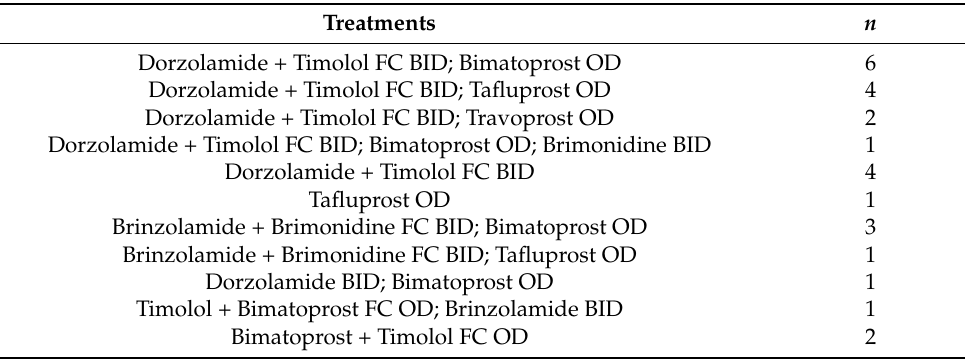
Table 1. Distribution of IOP-lowering treatments in Med Eyes. Treatments n Dorzolamide + Timolol FC BID; Bimatoprost OD 6 Dorzolamide + Timolol FC BID; Tafluprost OD 4 Dorzolamide + Timolol FC BID; Travoprost OD